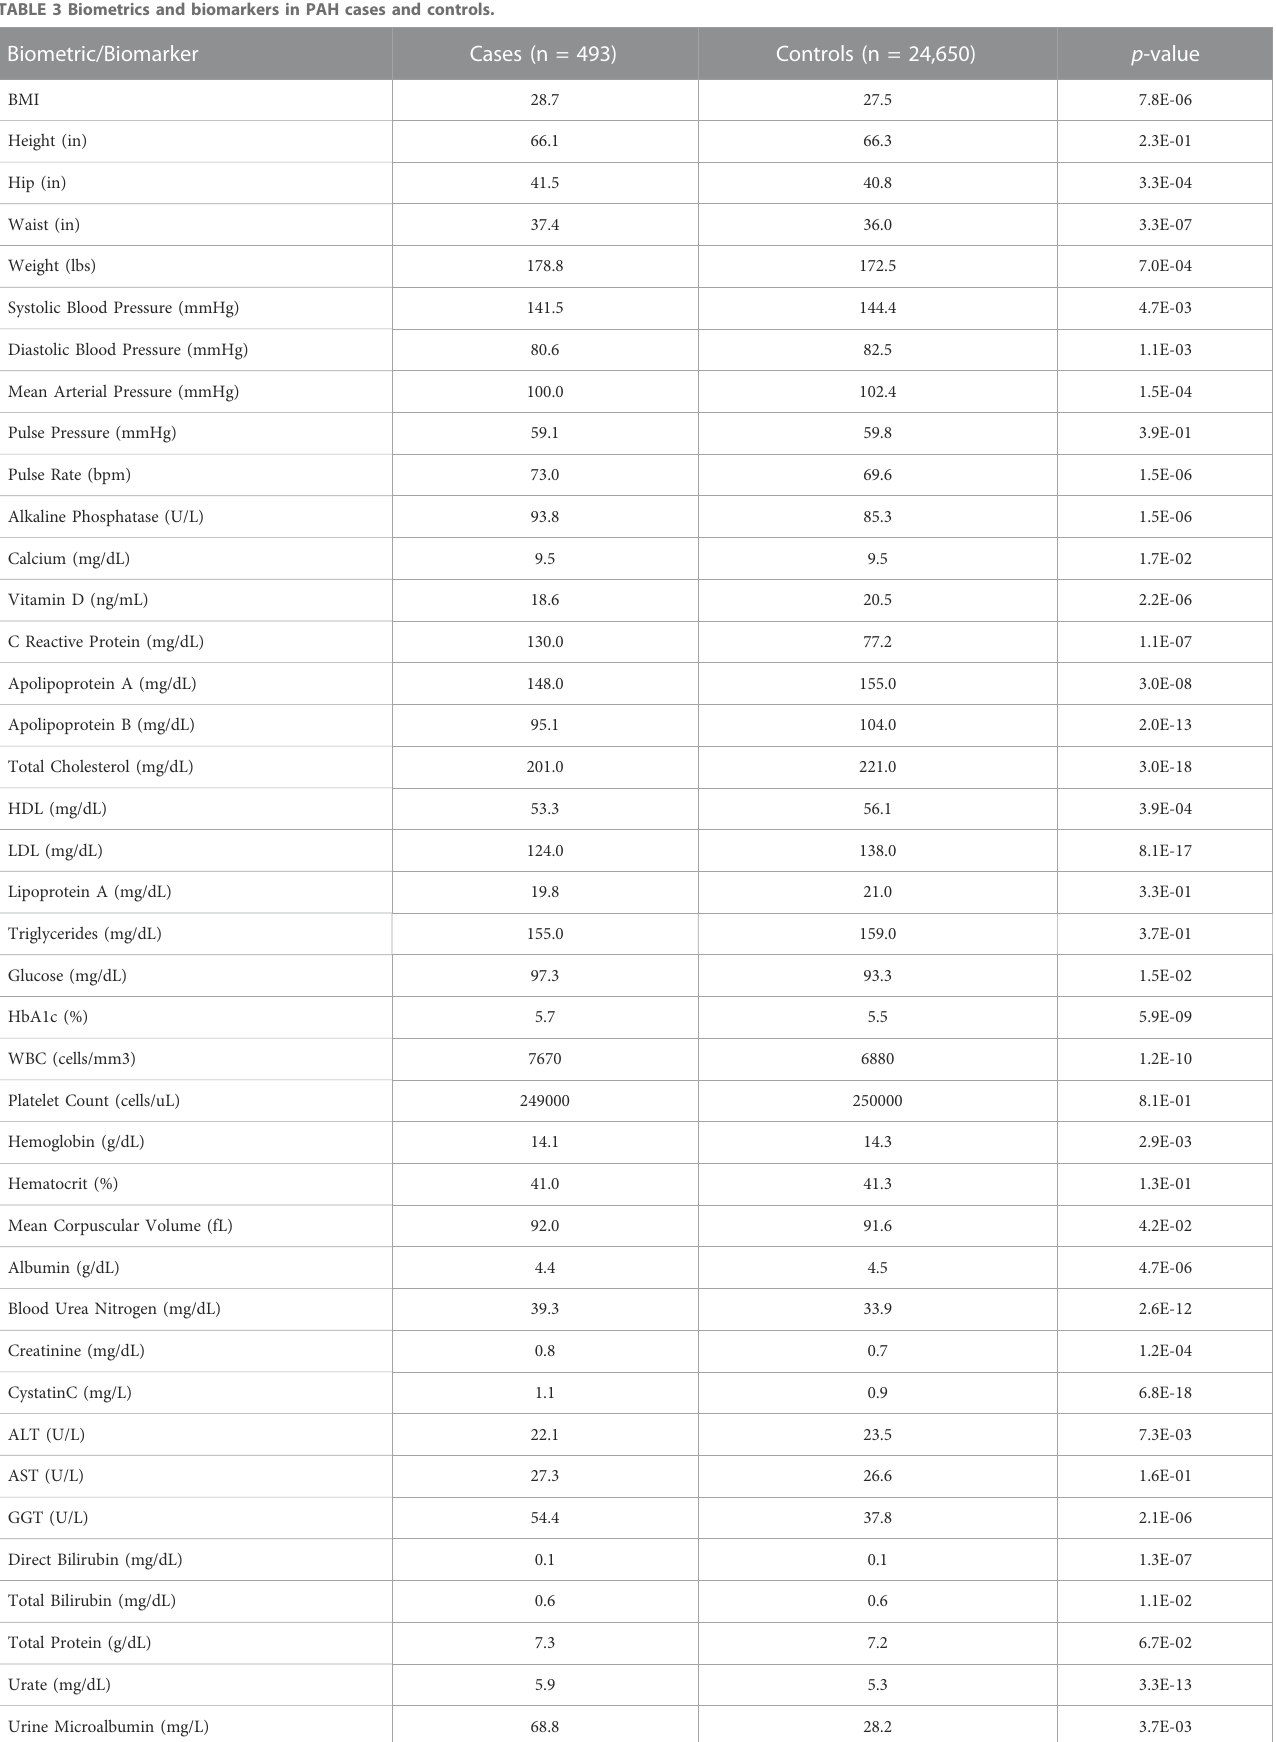
TABLE 3 Biometrics and biomarkers in PAH cases and